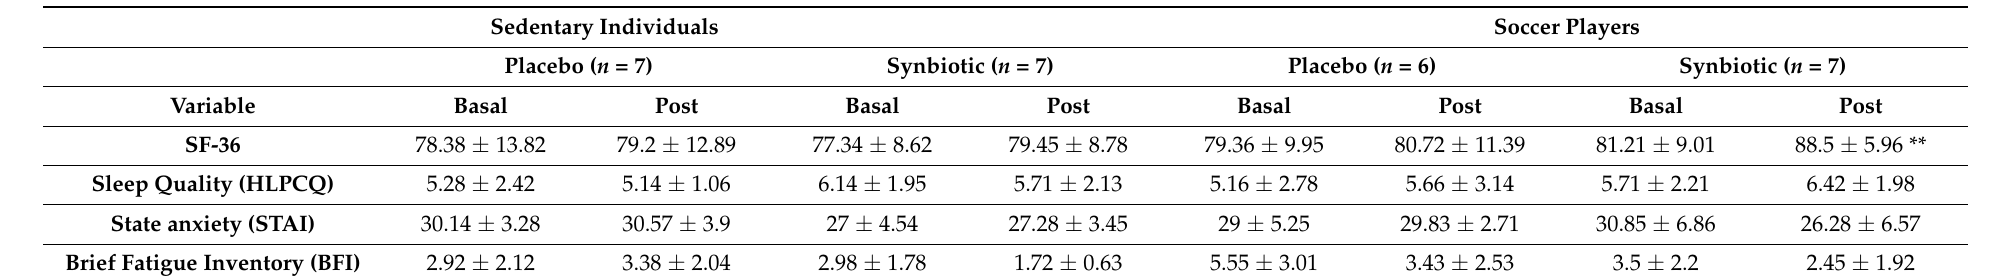
Table 3. Perceived levels of general health, state anxiety, fatigue, and sleep quality. Sedentary Individuals